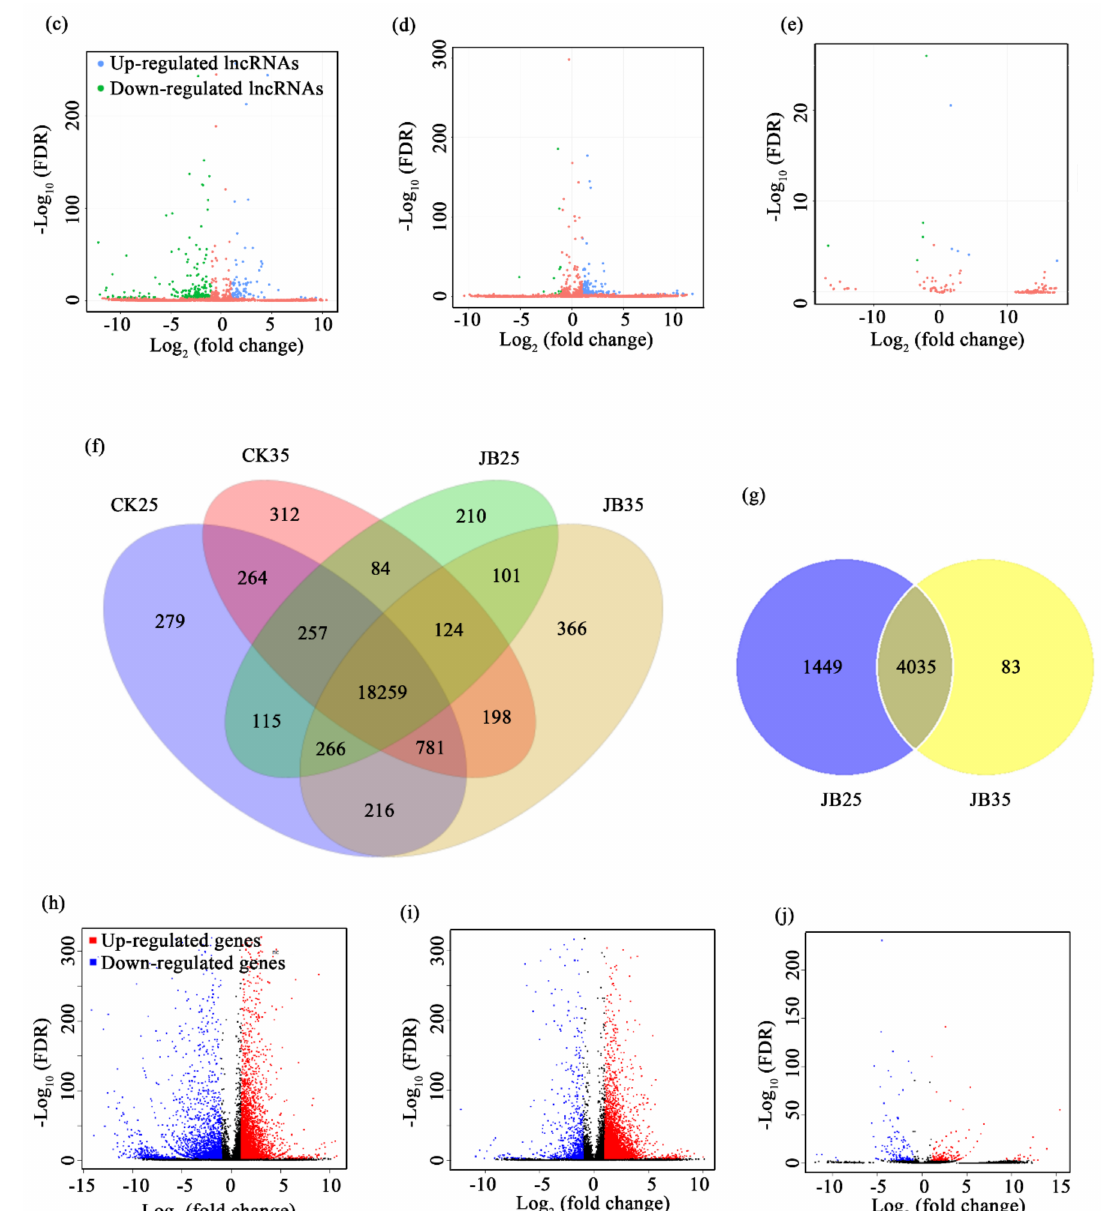
Figure 2. Expression of lncRNAs and mRNAs in Zizania latifolia and Ustilago esculenta . ( a ) Venn diagram showing the shared and distinct lncRNA expression in Z. latifolia . ( b ) Venn diagram showing the shared and distinct lncRNA expres-sion in U. esculenta ; ( c ) Volcano map of differentially expressed lncRNAs in Z. latifolia between culms of Z. latifolia infected with U. esculenta grown at 25 ◦ C (JB25) and 35 ◦ C (JB35). ( d ) Volcano map of differentially expressed lncRNAs in Z. latifolia between culms of Z. latifolia without U. esculenta infection grown at 25 ◦ C (CK25) and 35 ◦ C (CK35). ( e ) Volcano map of differentially expressed lncRNAs in U. esculenta between JB25 and JB35 plants. ( f ) Venn diagram for the genes expressed in Z. latifolia . ( g ) Venn diagram for the genes expressed in U. esculenta from Z. latifolia plants infected with U. esculenta . ( h ) Volcano map of differentially expressed genes of Z. latifolia between JB25 and JB35 plants. ( i ) Volcano map of differentially expressed genes of Z. latifolia between CK25 and CK35 plants. ( j ) Volcano map of differentially expressed genes of U. esculenta between JB25 and JB35